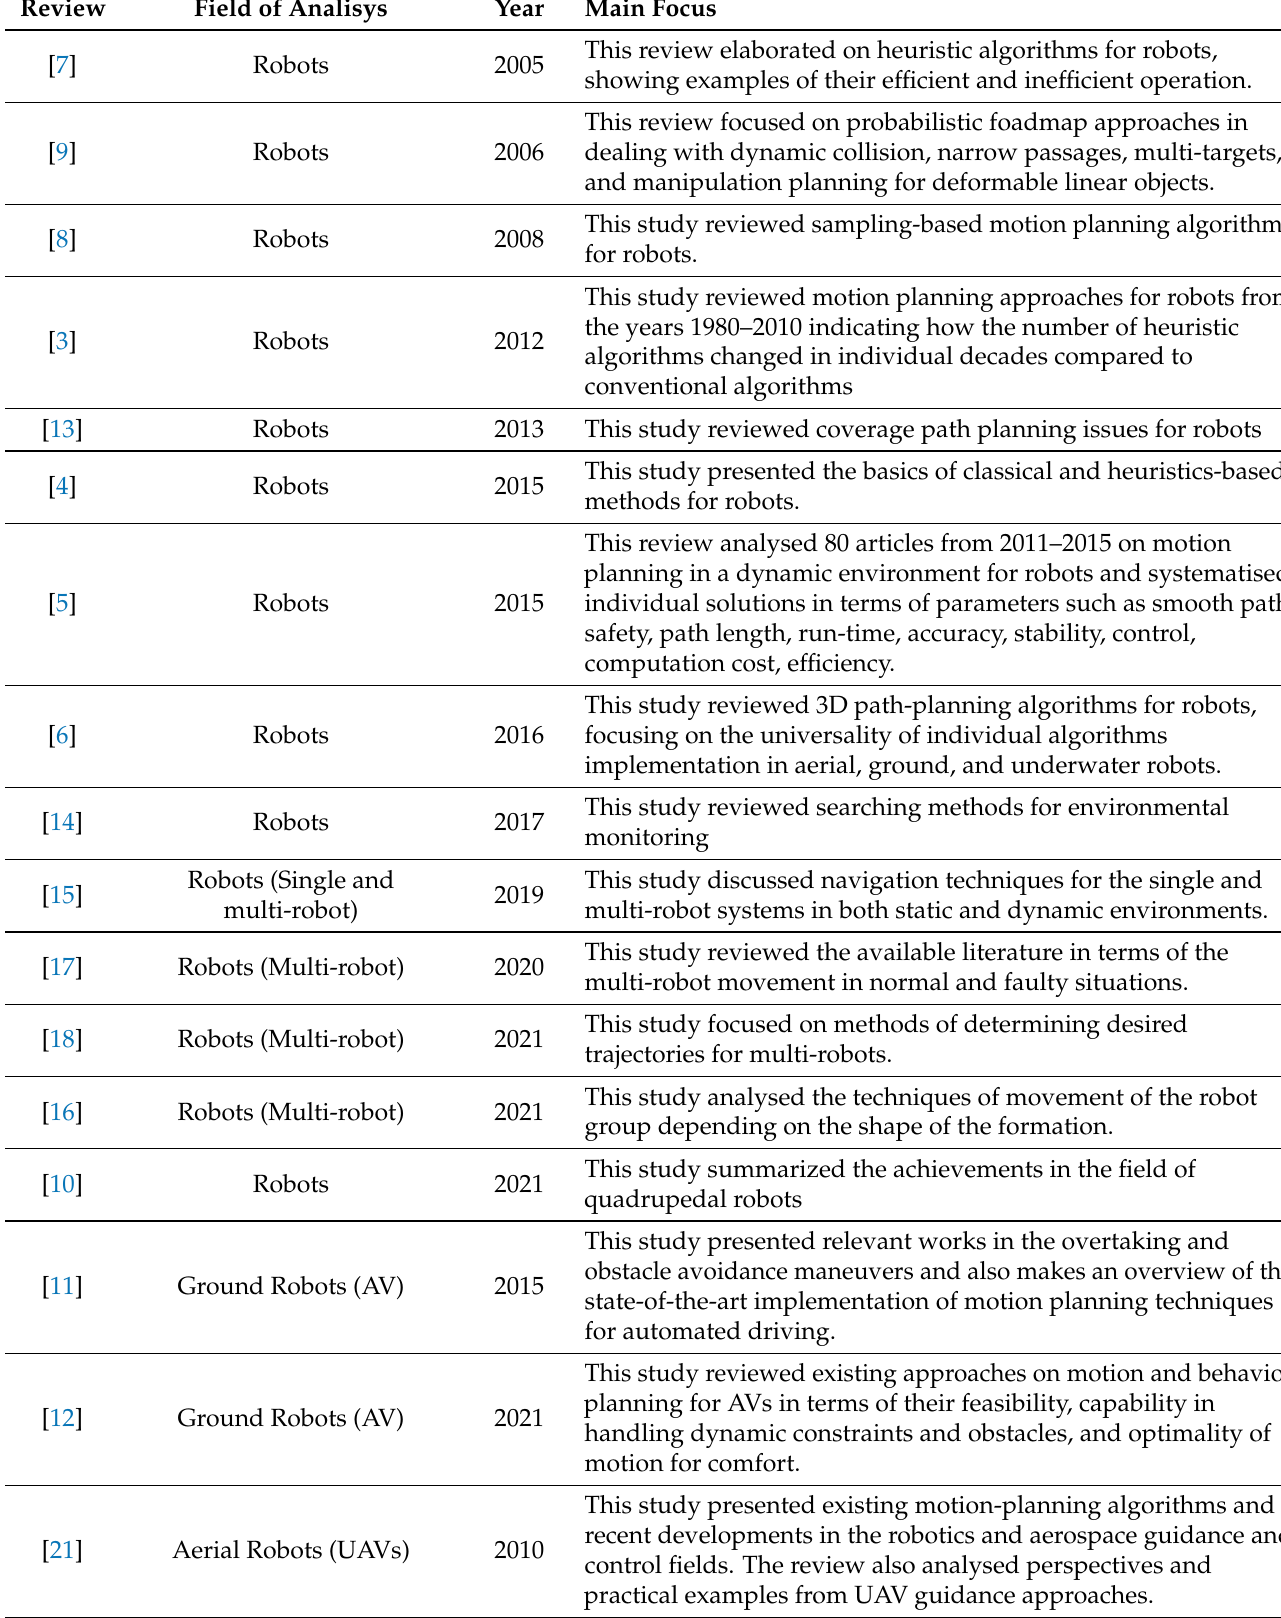
Table 1. Surveys connected with motion planning for